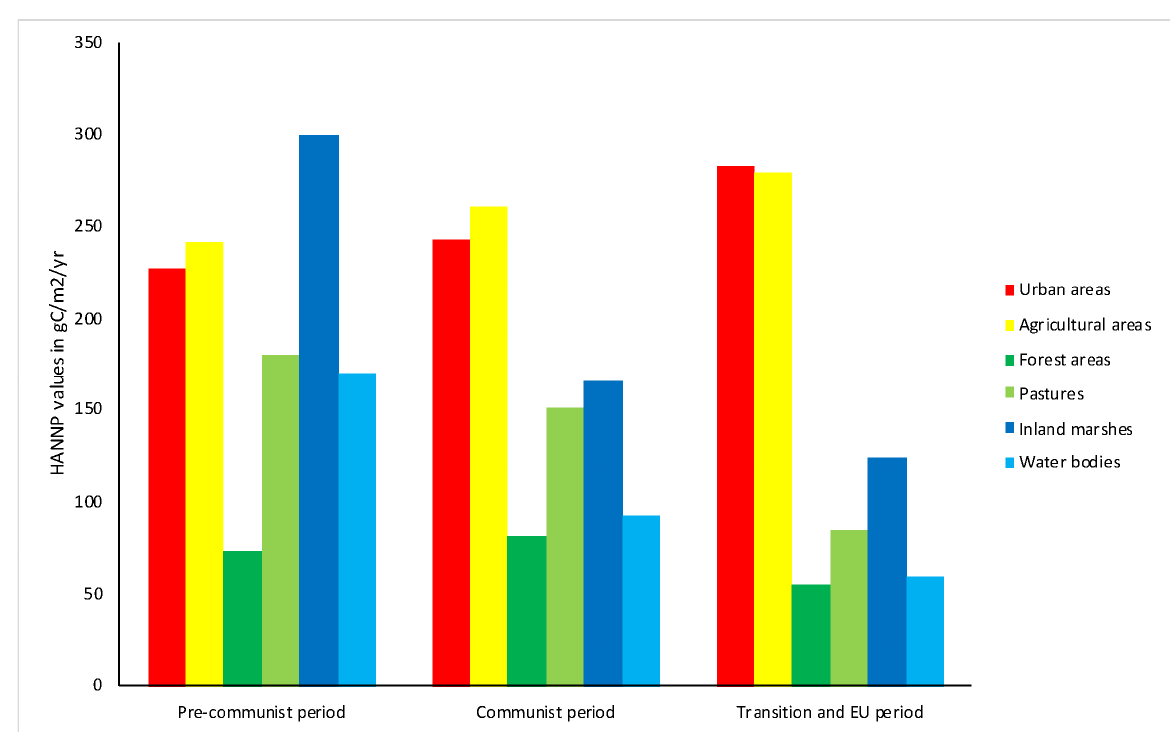
Figure 7. The HANPP values of each of the land cover classes.